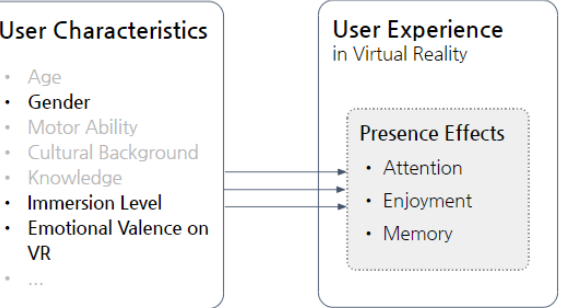
Figure 1. The concept of the user characteristics and presence effects that this study explores. The user characteristics that are not part of this study are grayed